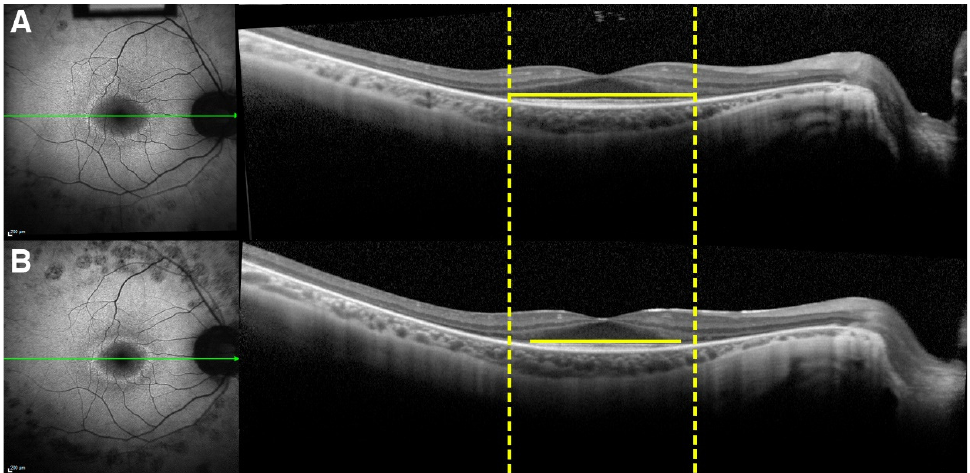
Figure 7. Ellipsoid zone (EZ) line progression in spectral domain–optical coherence tomography (SD-OCT) imaging of a patient with retinitis pigmentosa (RP). Green lines represent the position of the horizontal OCT scan with respect to the autofluorescence image. Dashed yellow lines are tangential to the lateral ends of the EZ line shown in the horizontal SD-OCT cross-section through the fovea at the baseline visit ( A ). The EZ line width, indicated by the span of the yellow lines, is greater at the baseline visit than at follow-up ( B ).